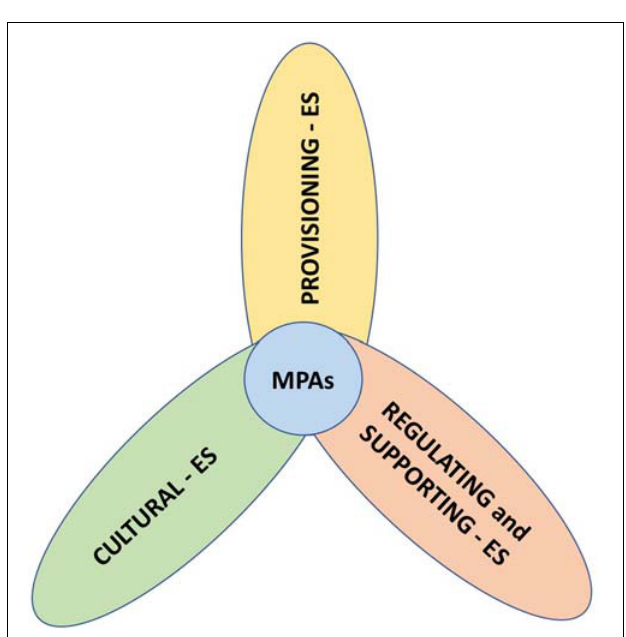
FIGURE 4 | MPAs as a tool for mapping the diverse range of ES including: Provisioning ES—Regulating and Supporting ES—Cultural ES.